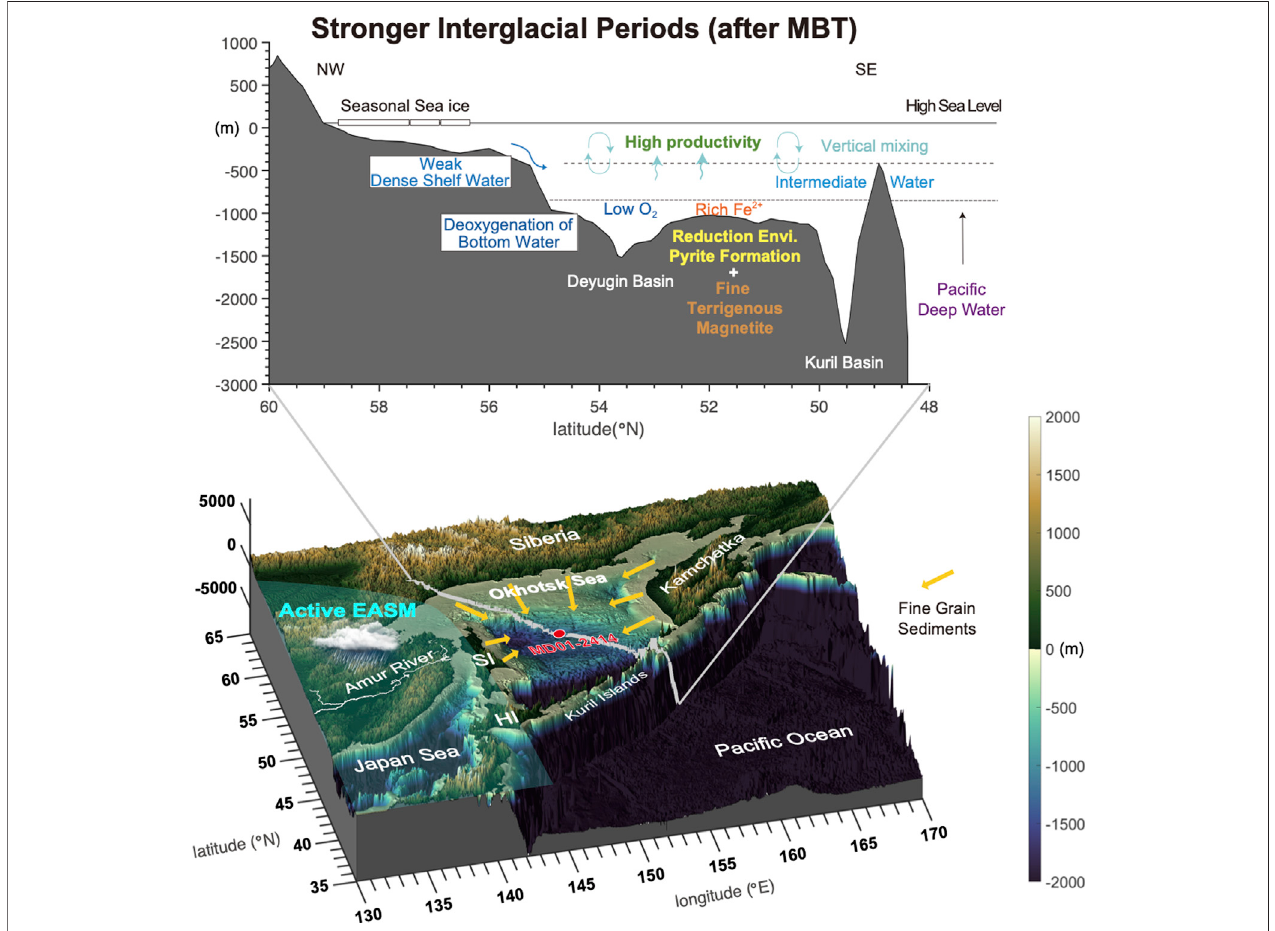
FIGURE 8 | Schematic cross-section and view of Okhotsk Sea displaying the terrigenous transportations and oceanographic conditions during stronger interglacial periods (post MBT). EASM: East Asian Summer Monsoon.